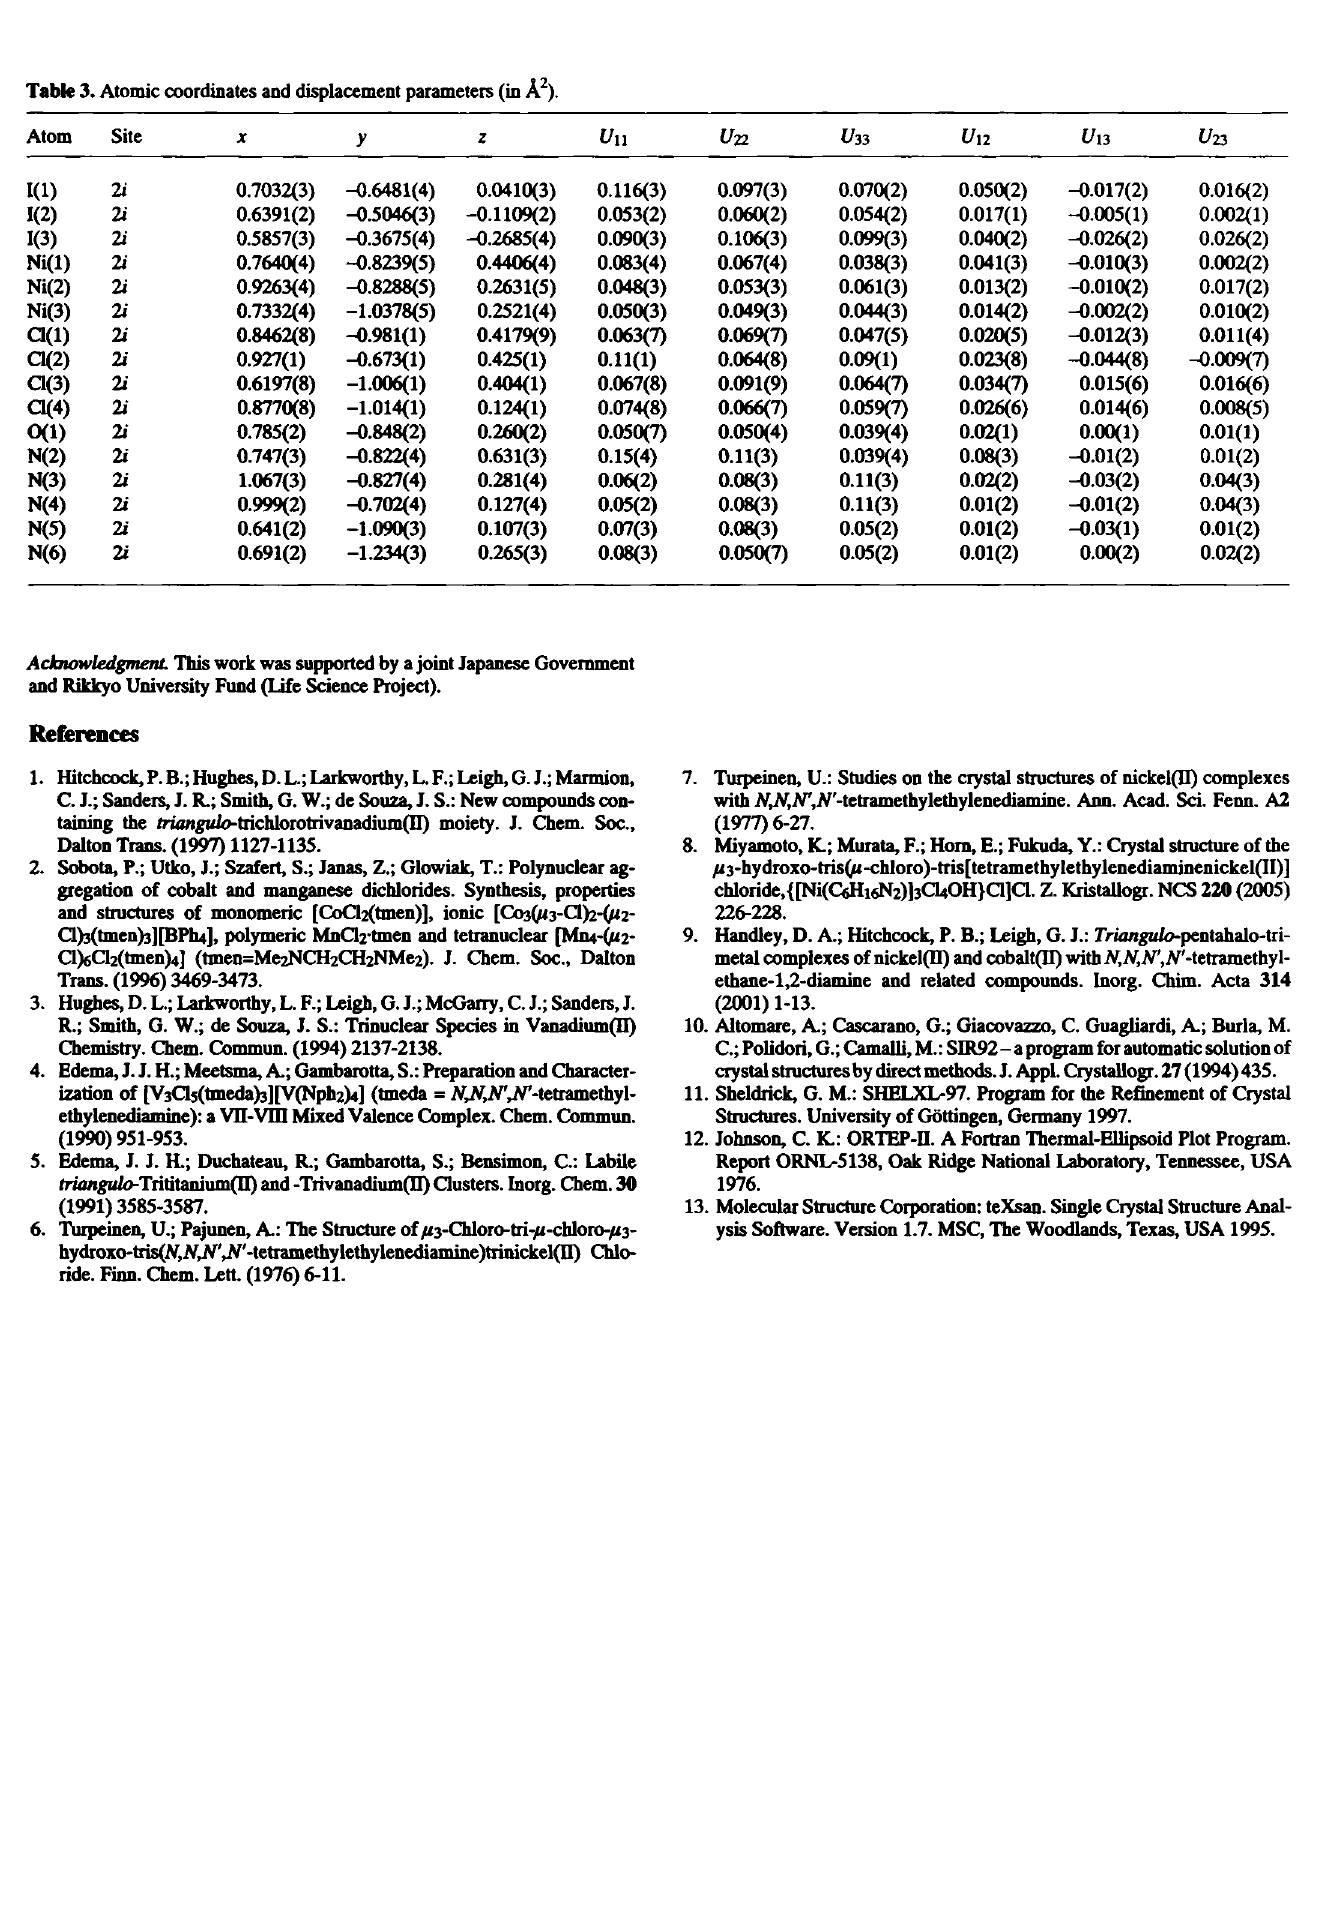
Table 3. Atomic coordinates and displacement parameters (in Ä 2